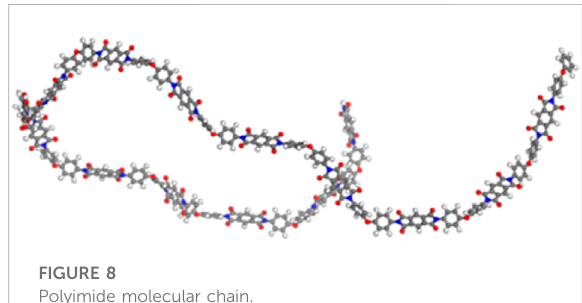
FIGURE 8 Polyimide molecular